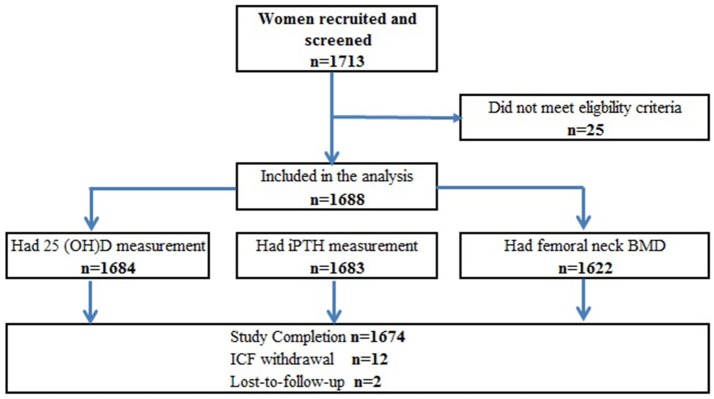
Study flowchart for enrolment. Four subjects had 25(OH)D < LLoQ and were not included in the analysis for the continuous variable. Subjects who had missing femoral neck DXA may have BMD measured at another anatomical site. Study completion was deemed as subjects who had all study procedures as per protocol. Subjects failed to return for the remained study procedure were deemed lost-to-follow-up. All subjects with non-missing data were included in the corresponding analysis.